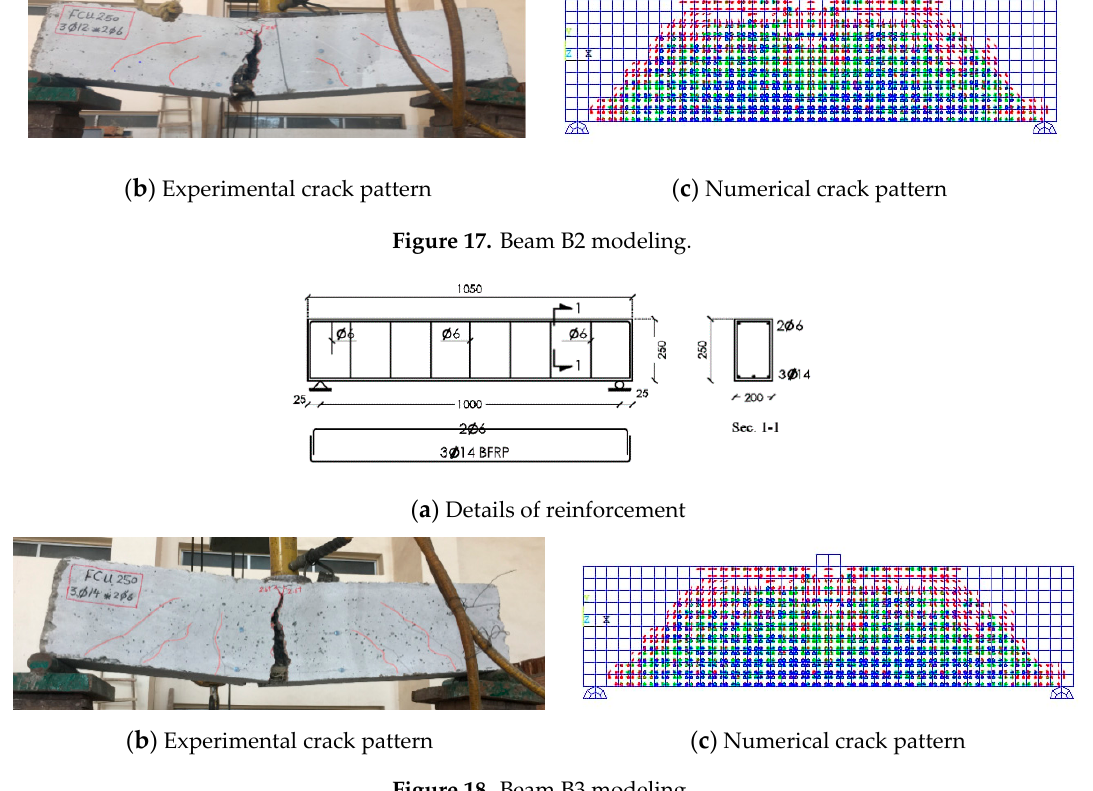
Figure 18. Beam B3 Figure 18. Beam B3 modeling.